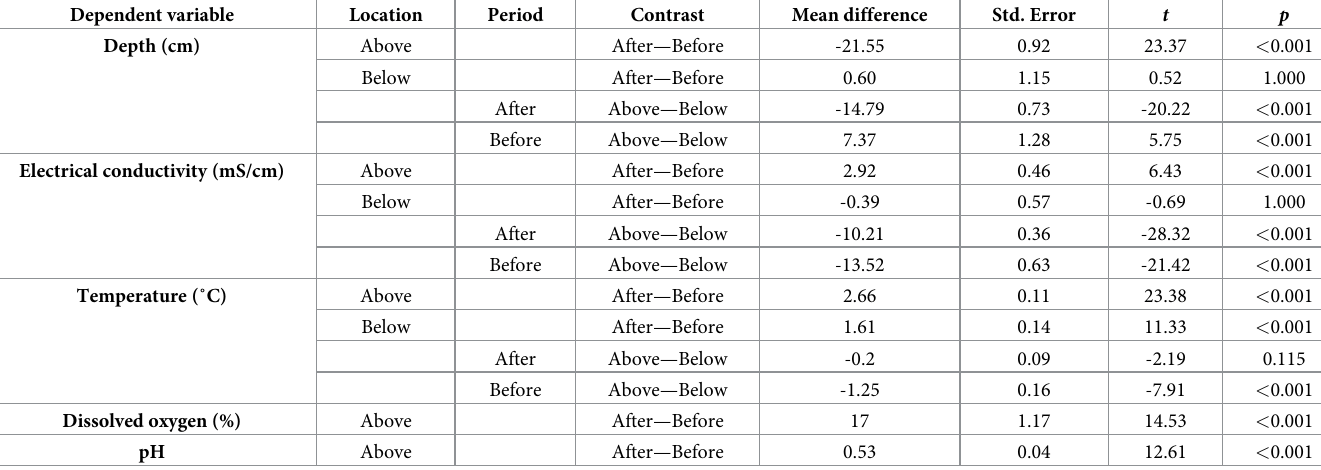
Table 1. Simple contrasts for water quality measurements for the above and below bund location and before and after bund removal combinations. Dependent